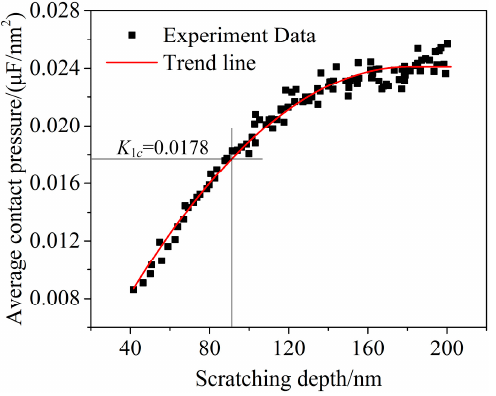
Figure 8. Average contact pressure as a function of scratching depth.